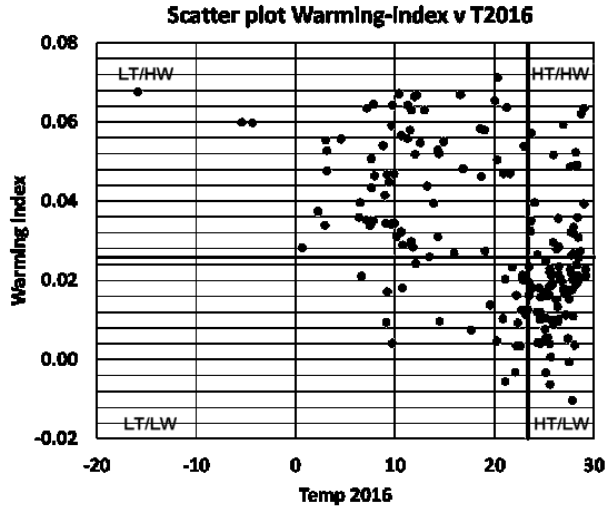
Figure 2. Scatter plot of the 1990 − 2016 warming index versus T2016. Each symbol represents one of the 184 analyzed countries (Table S1). The horizontal and vertical lines divide the countries in the four categories high/low temperature, high/low warming.